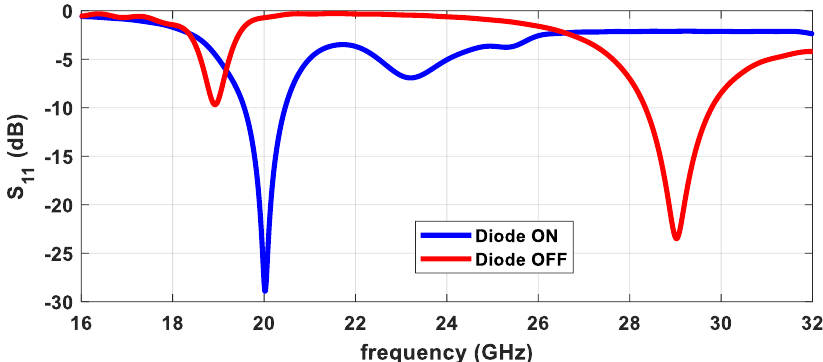
Figure 5. Simulated S 11 of the individual patch antenna for both states of the PIN diode.